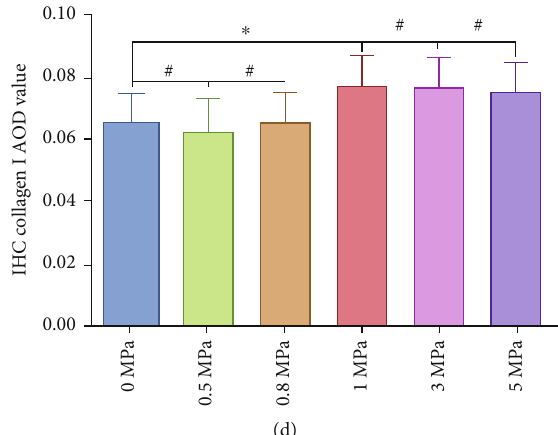
Figure 4: E ff ect of hydrostatic pressure on synthesis of collagen type I of the rabbit notochordal NP and fi brocartilaginous inner AF: (a) collagen type I IHC staining of the notochordal NP under graded hydrostatic pressure (200x); (b) statistic analysis of IHC collagen type I AOD value of the notochordal NP under graded hydrostatic pressure; (c) collagen type I IHC staining of the fi brocartilaginous inner AF under graded hydrostatic pressure (200x); (d) statistic analysis of IHC collagen type I AOD value of the fi brocartilaginous inner AF under graded hydrostatic pressure. ∗ P < 0 : 05 . # P > 0 : 05 . Scale bar = 100 μ